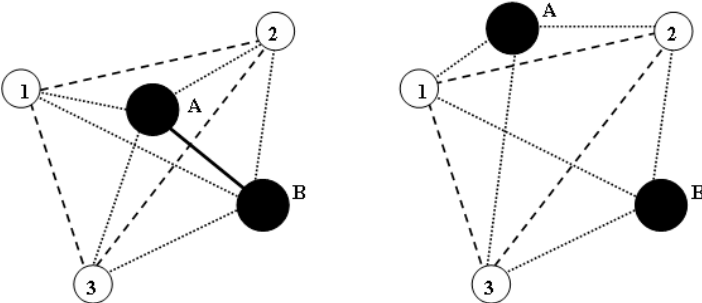
Figure 1. Representation of the Honeycutt-Anderson method. The continuous line shows a root pair which makes a bond with each other. A dotted line indicates the neighbor atoms which bond with a root pair. A dashed line represents the bonds between neighbor atoms. The figure shows ( left ) 1331 bonded pair and ( right ) 2331 non-bonded pair.